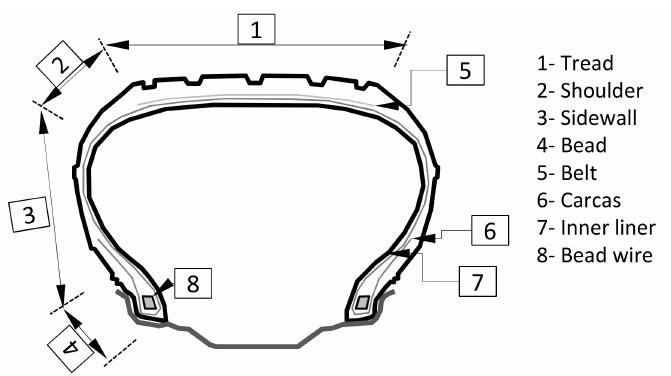
Figure 1. Cross-section of